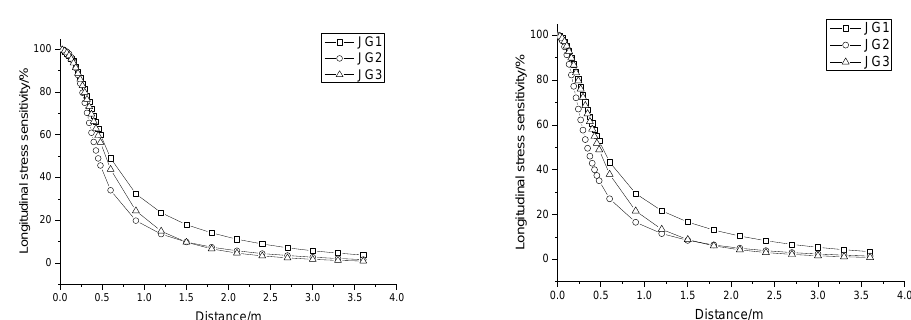
Figure 6. Longitudinal stress sensitivity of the base layer bottom of three structures (unit: %).